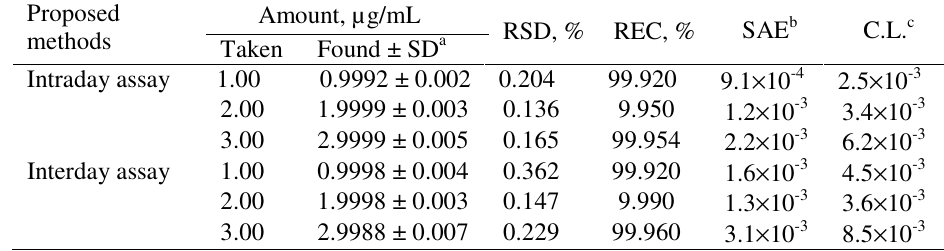
Table 2. Summary of accuracy and precision results of the proposed method in pure form.